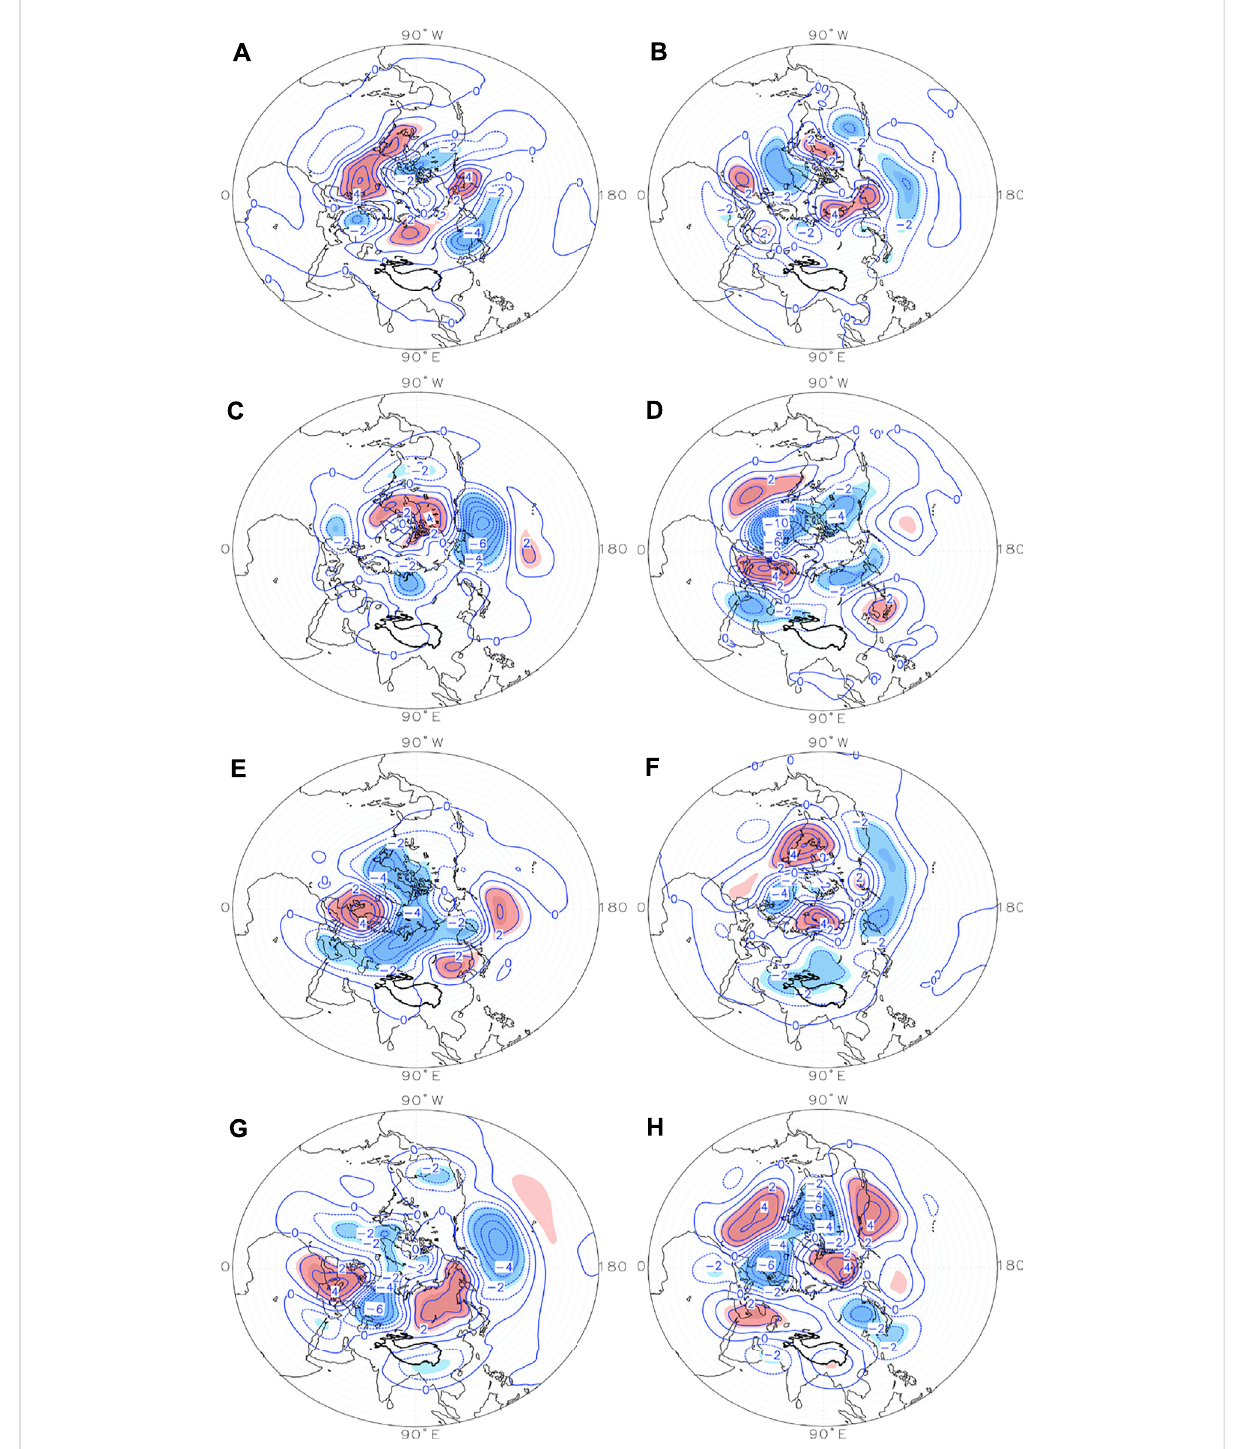
FIGURE 8 Thecomposite500 hPageopotentialheightanomalyofwinterFATinpreviousOctober (A,B) ,November (C,D) ,December (E,F) andanomalous January (G,H) in the northern hemisphere. A, C, E and G are the stronger FAT years, and B, D, F and H are the weaker FAT years. The shadow is the same as Figure